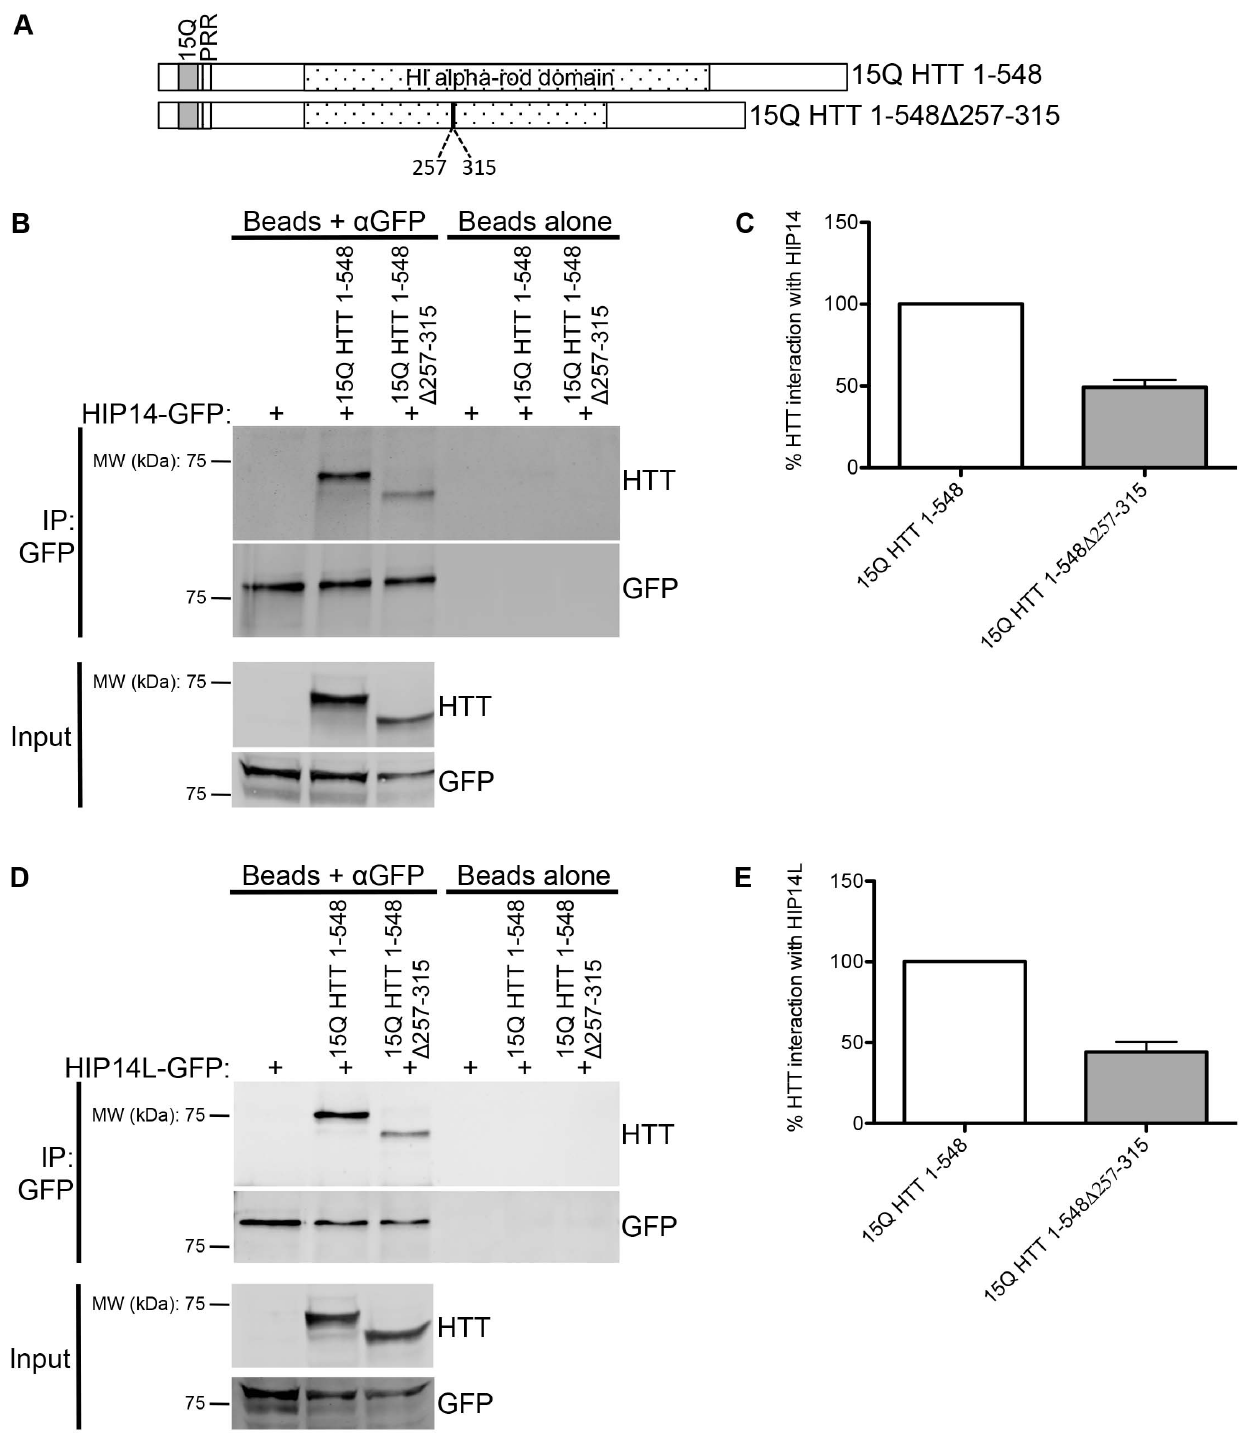
Figure 4. HIP14 and HIP14L interaction with 15Q HTT 1-548 D 257-315. ( A ) A diagram of the 15Q HTT 1-548 D 257-315 deletion mutant used in co-immunoprecipitation experiments with HIP14-GFP and HIP14L-GFP showing the 15Q poly-Q domains, the proline rich region (PRR), and the H1 alpha-rod domain. ( B ) A representative image (top two panels) of the co-immunoprecipitation between 15Q HTT 1-548 D 257-315 deletion mutant and HIP14-GFP where GFP was immunoprecipitated and the resulting blots were probed for HTT (top panel) and GFP (bottom panel) showing less of the 15Q HTT 1-548 D 257-315 deletion mutant co-immunoprecipitated with HIP14-GFP and compared to 15Q HTT 1–548. On the right is a beads alone (no antibody) control showing no non-specific binding of the proteins to the beads. The bottom two images show the expression of the 15Q HTT 1- 548 D 257-315 deletion mutant (top panel) and of HIP14-GFP (bottom panel). ( C ) Quantification of three independent co-immunoprecipitation experiments where the % HTT interaction with HIP14 is the indicated HTT band intensity as a percentage of the HIP14-GFP band intensity from the